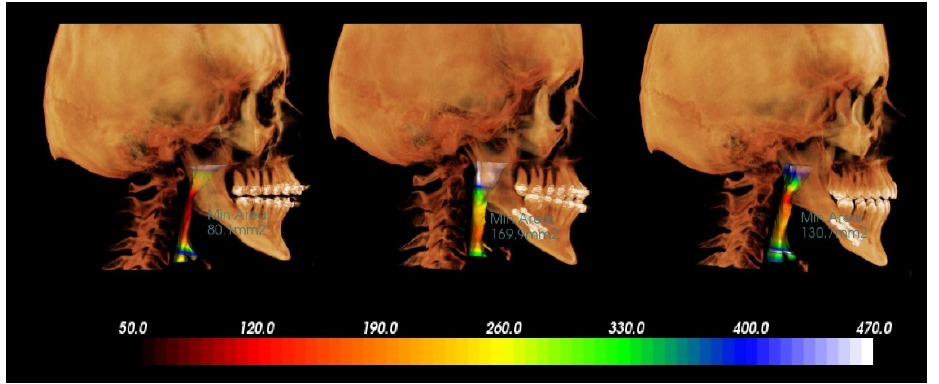
Figure 2. Illustration of minimum cross-sectional area changes following mandibular advancement surgery, left side: before surgery, middle: 2 weeks following surgery, right side: 1 year after surgery.